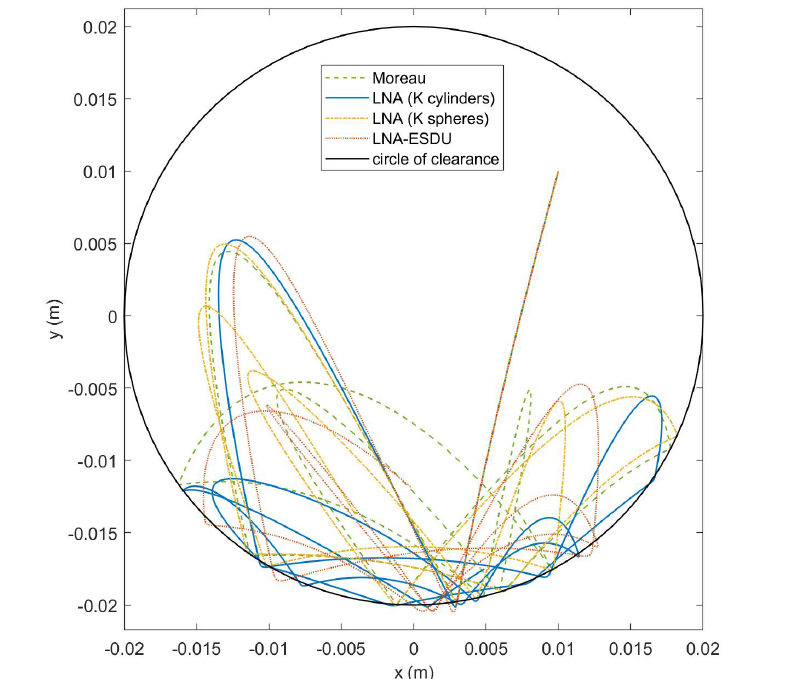
Figure 12. Trajectory of the body–center G 1 for the four models. Starting point at q 0 = [ 0.01,0.01,0 ] T .